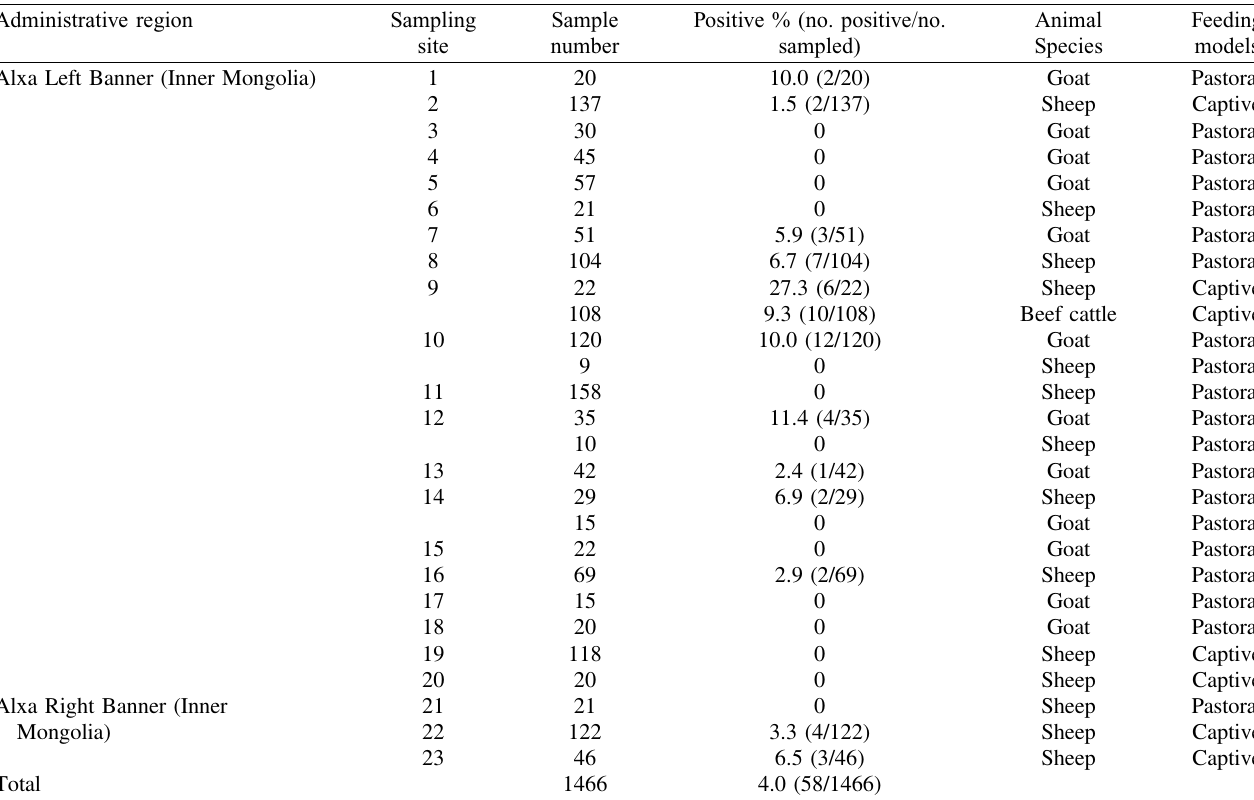
Table 1. Sampling information and the occurrence of G. duodenalis in ruminants in Southwest Inner Mongolia, China. Administrative region